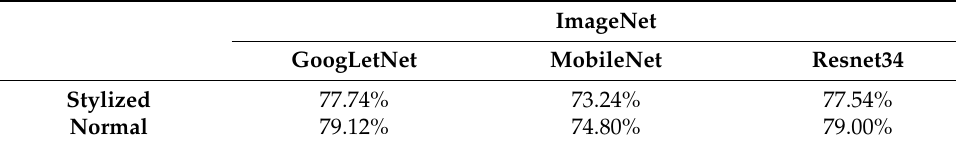
Table 2. The accuracy rate of the models with stylized pairing training and normal training on ImageNet. Stylized denotes stylized pairing training and Normal refers to normal training without stylized